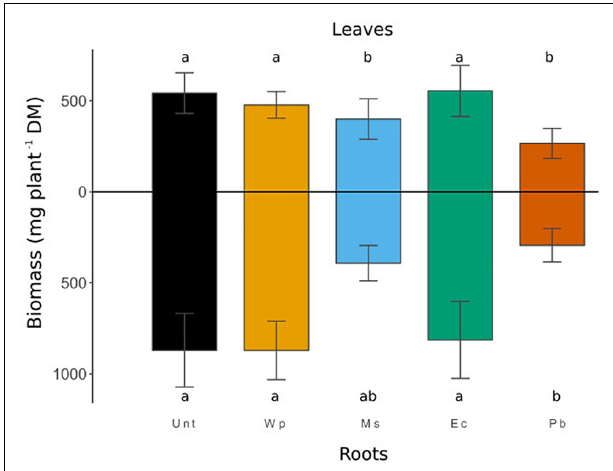
FIGURE 3 | Root and leaf DM yields of birch plants (mg/plant) harvested after a 3-month growth period. Values shown represent (means ± SD) the results of 12 replicates. Identical letters indicate that no significant differences ( p < 0.05) occurred in the birch biomass across the various treatments.